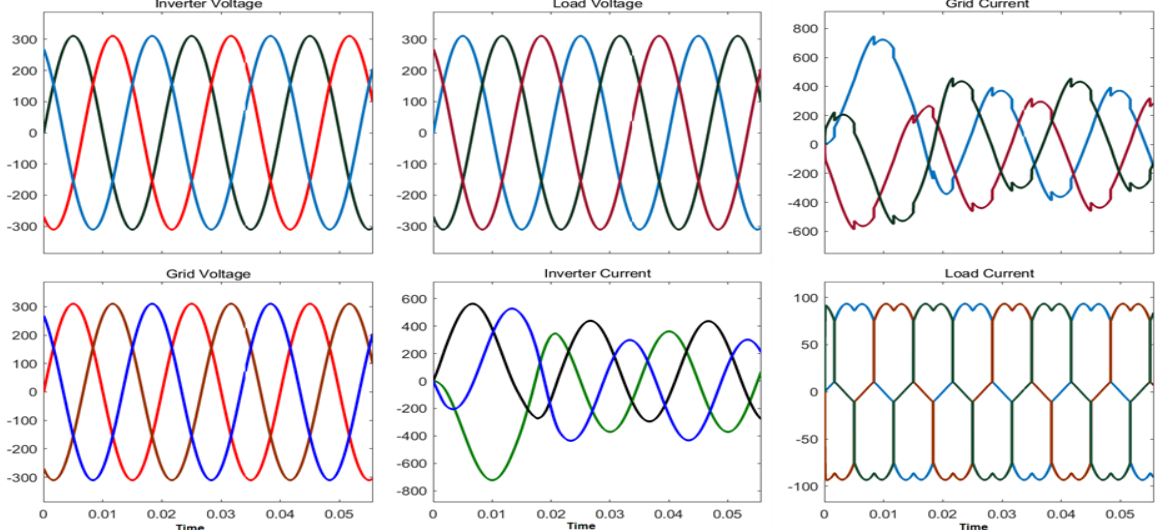
Figure 10. Voltage and current performance of the solar PV system under nonlinear load and variation solar radiation under linear load = 60 kW, non- linear load (P = 20 kW and Q = 100 VAR) and variation solar radiation.